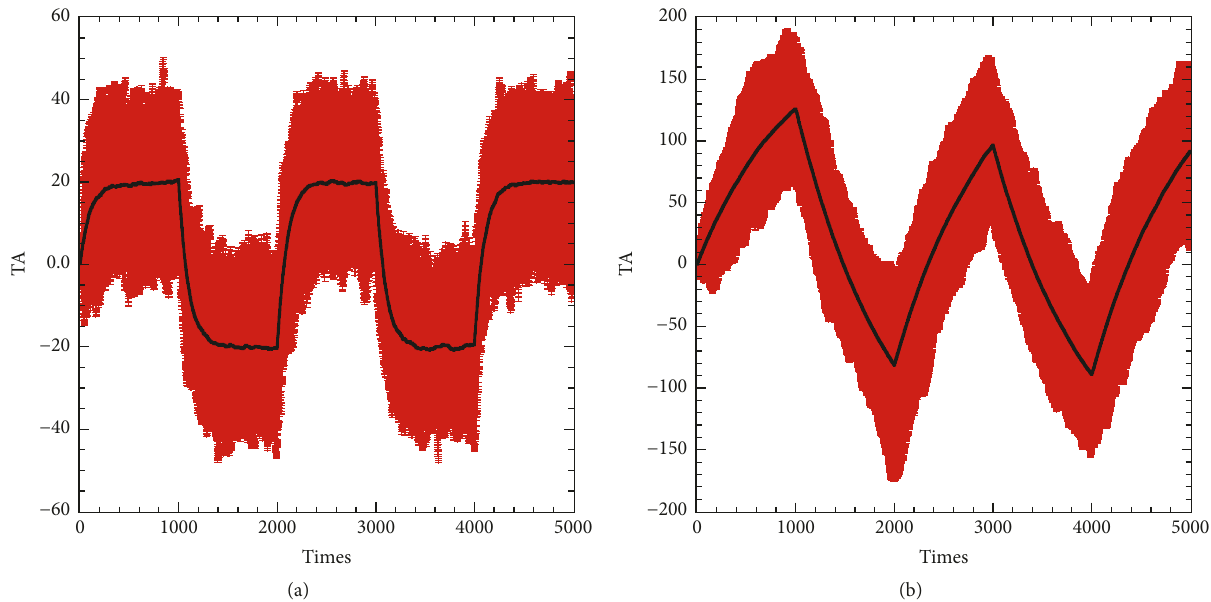
Figure 5: Time evolution of the threshold adjuster (TA) variable for (a) 𝛼 = 0.990 and (b) 𝛼 = 0.999. The red line indicates TA for 1000 cycles at the 𝑡 th trial, and the black line indicates the average TA over 1000